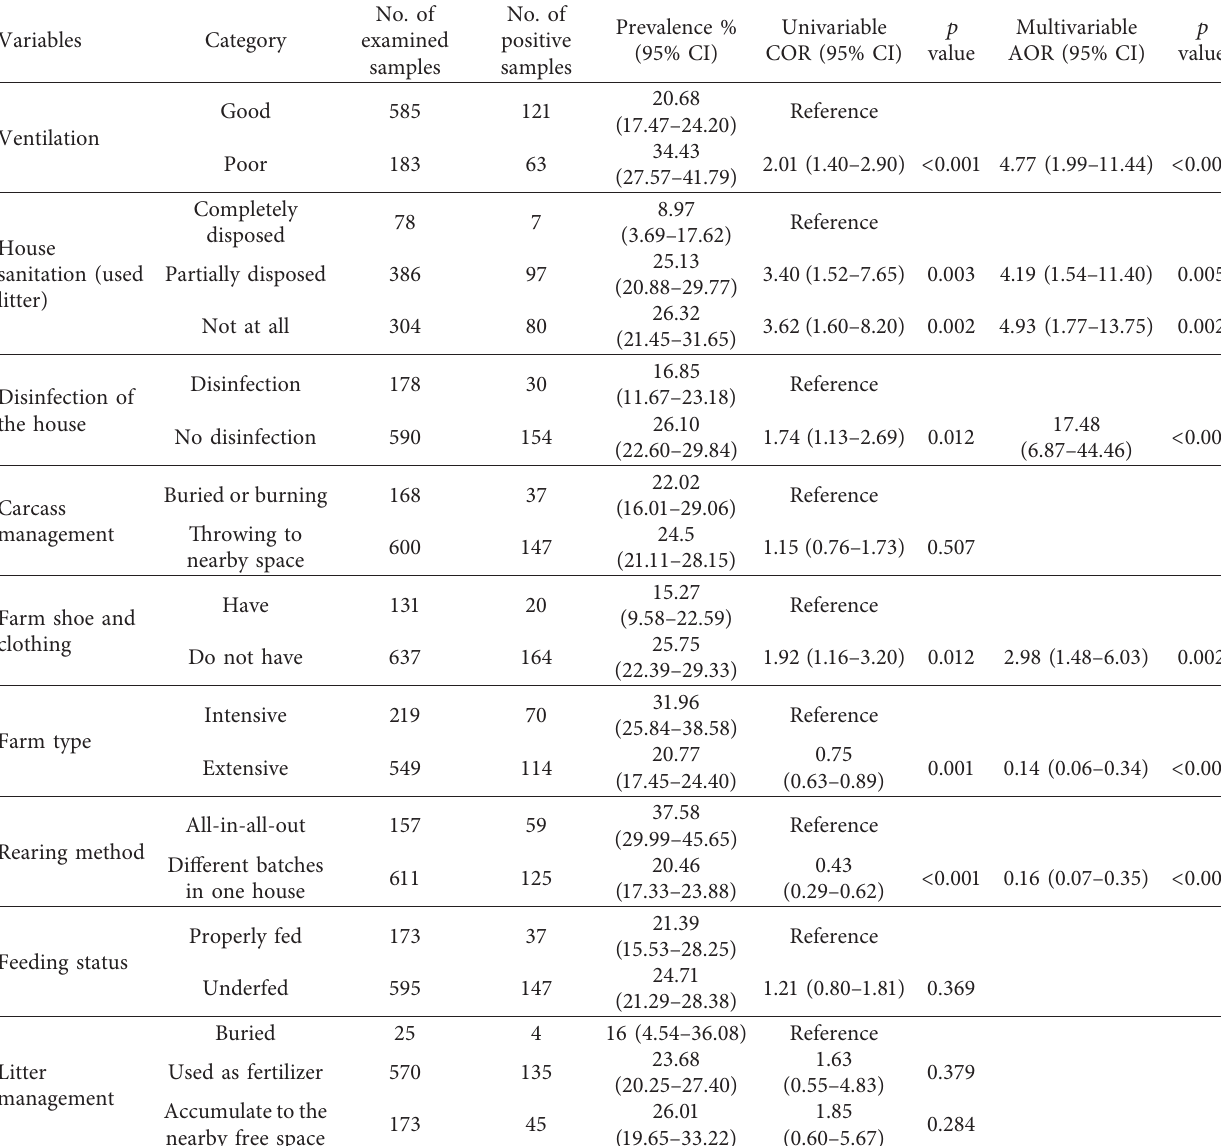
Table 3: Univariable and multivariable mixed-effect logistic regression analysis of environmental risk factors for infectious bronchitis